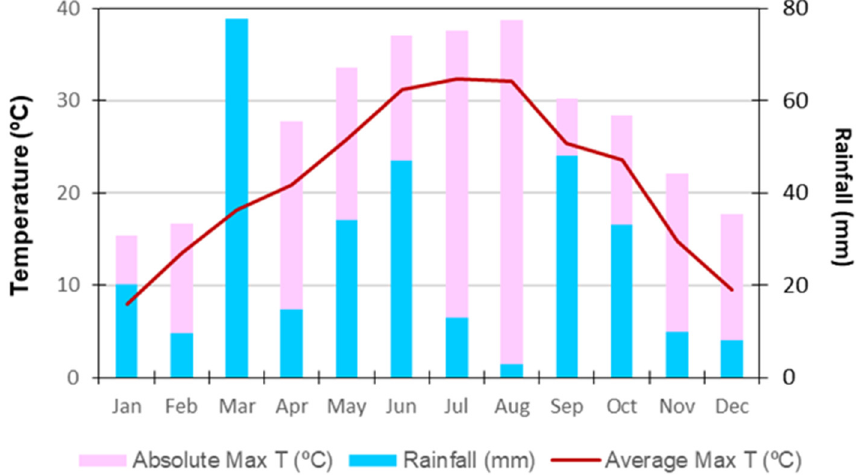
Figure 1. Rainfall and maximal (absolute and average) temperatures at the growing site (El Soleràs; 41°24 ′ N; 0°40 ′ E; altitude 450 m) in 2017. Fruit samples were harvested from either rain-fed trees or from trees supplied with drip irrigation (1.01 L m − 2 day − 1 , corresponding to 100% of daily crop